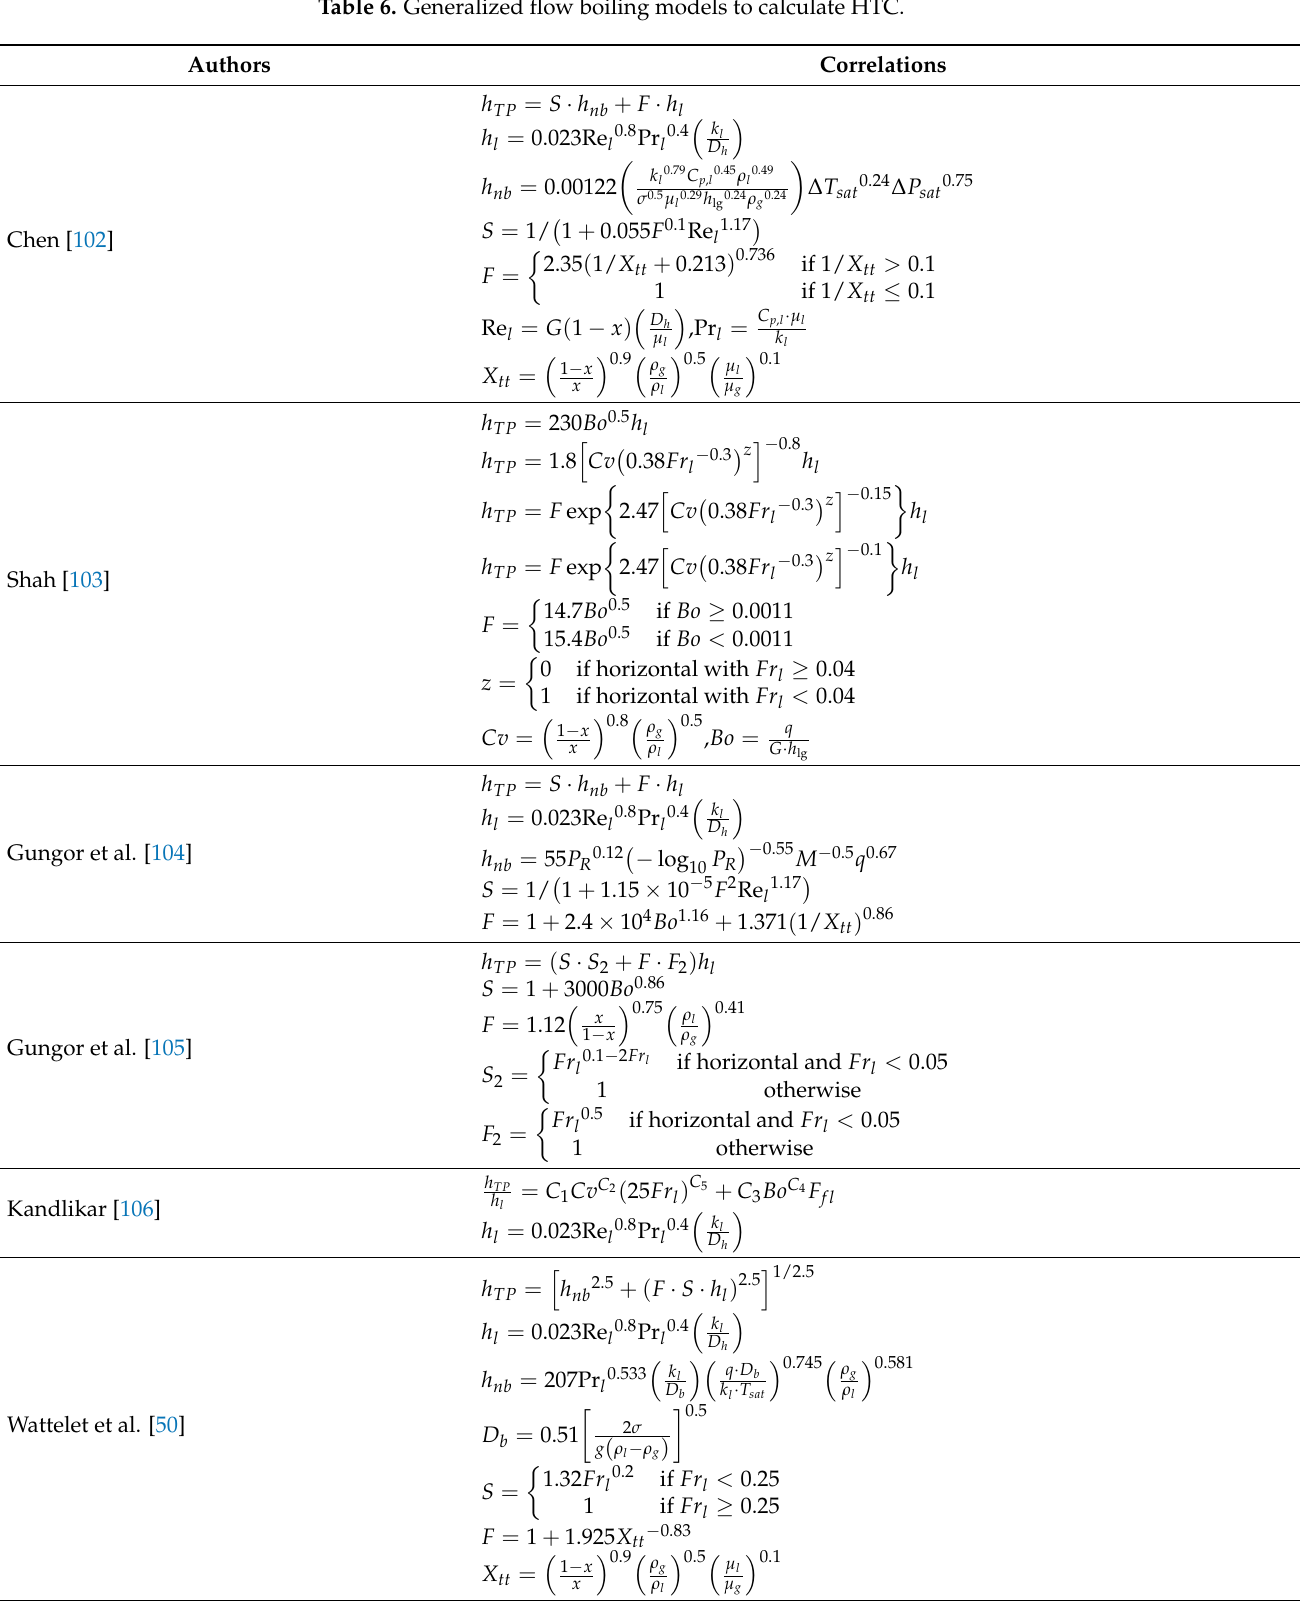
Table 6. Generalized flow boiling models to calculate